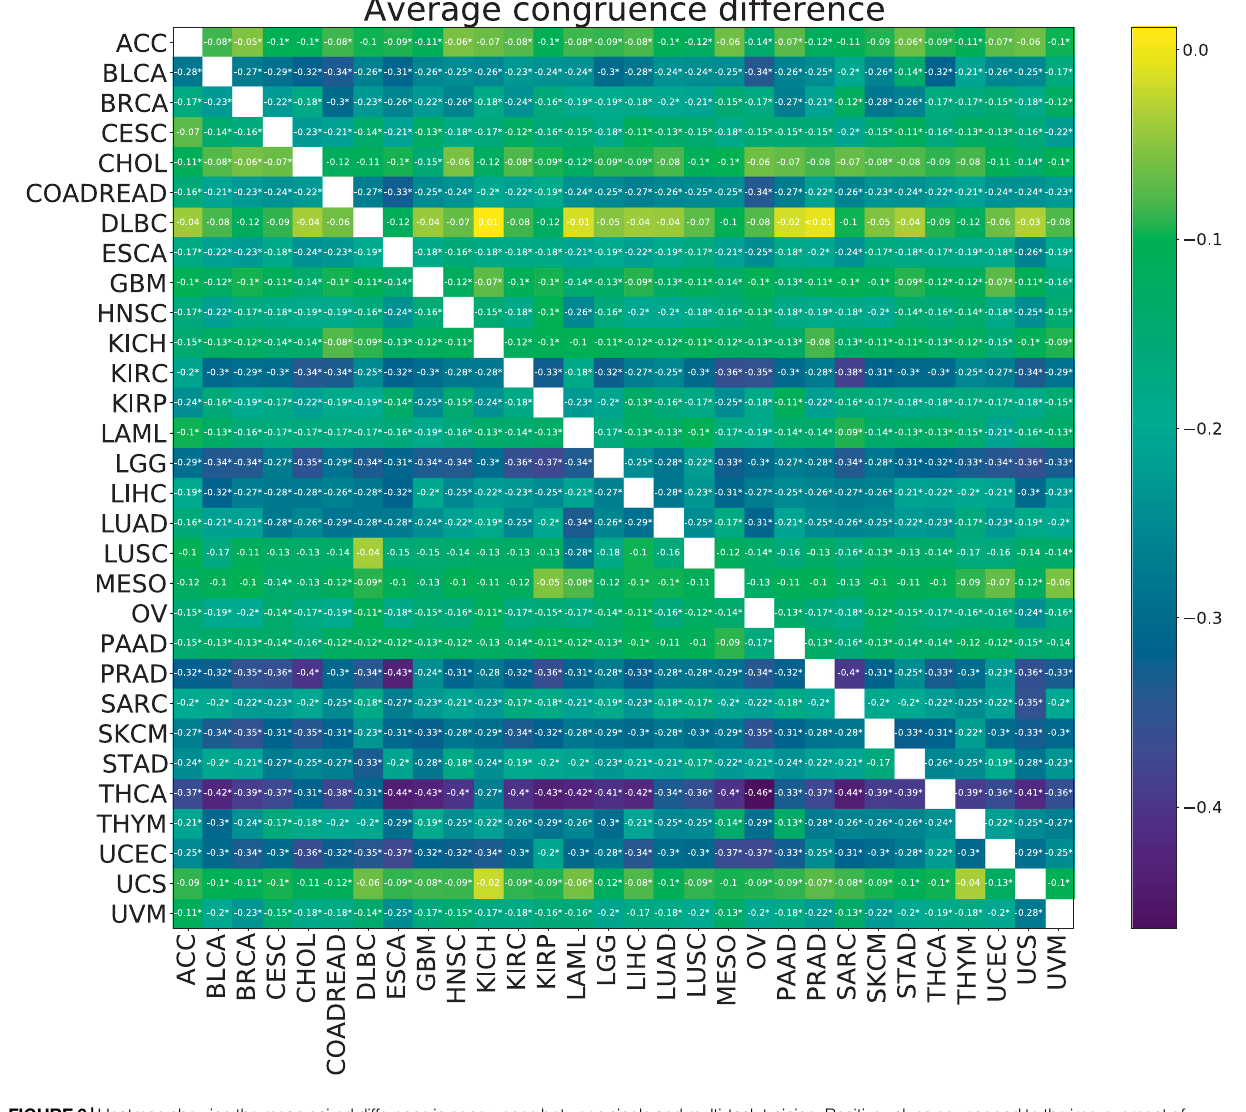
Frontiers in Genetics |